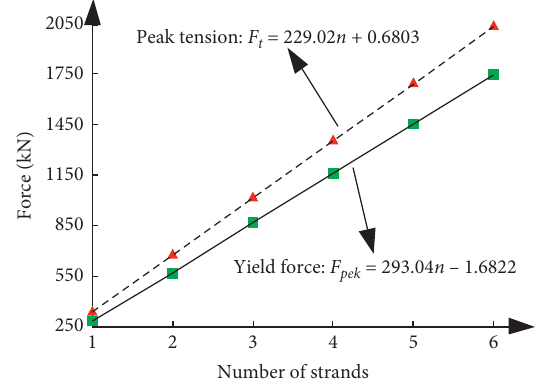
Figure 3: Experience curve of tension-strand quantity relationship.